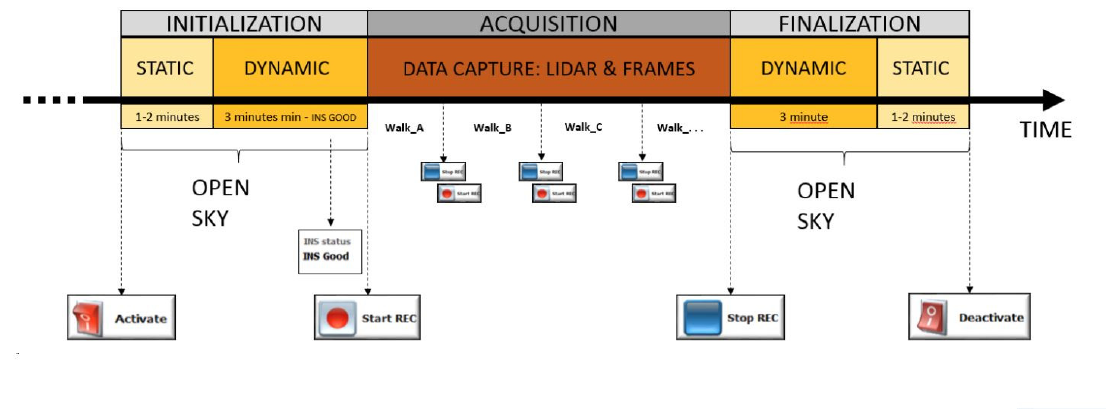
Figure 7. Workflow with Leica Pegasus Backpack (Leica Geosystems AG) [49]